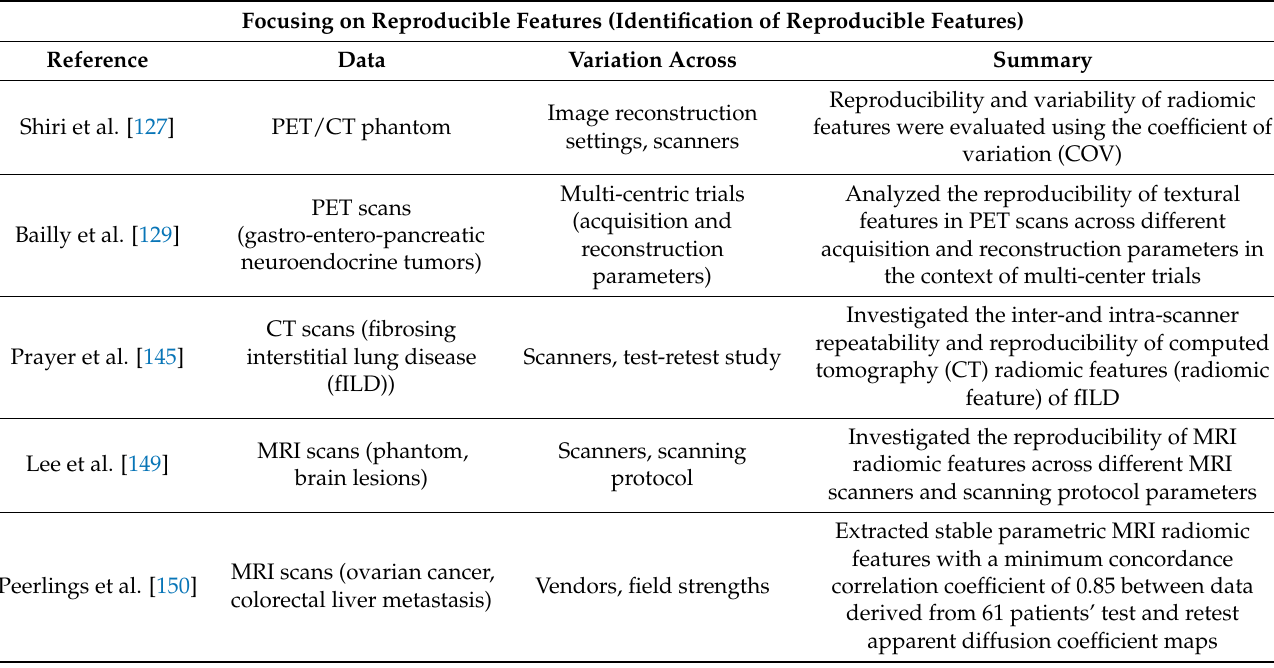
Table 5. Summary table of literature which focused on identification of reproducible features. Focusing on Reproducible Features (Identification of Reproducible